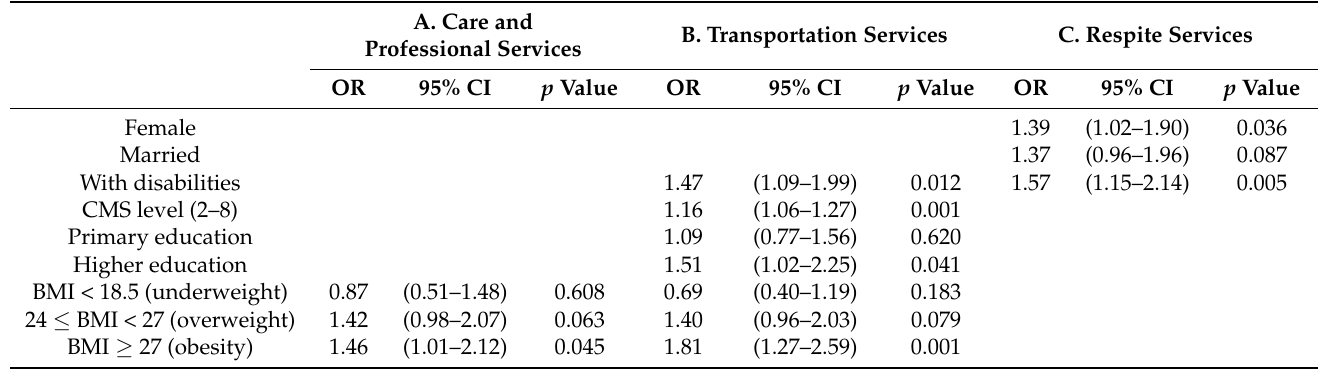
Table 2. Backward stepwise regression model for factors in referrals to LTC